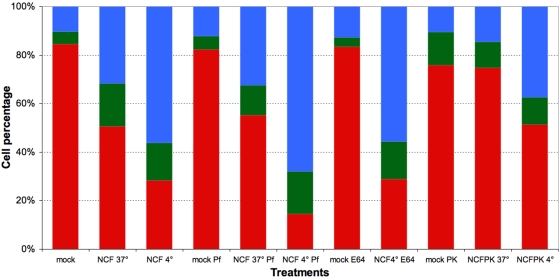
Effect on splenocyte survival of diverse pretreatments applied to the non-cytosolic trypanosome fraction (NCF).Splenocytes were exposed for 75 min to the non-cytosolic fraction corresponding to 4 108 trypanosome equivalents per ml. Mock, PBS; NCF 37°C and 4°C, non-cytosolic fraction kept at 37 or 4°C respectively for 24 h prior to incorporation onto the cells; Pf, E64 and PK, treatment of NCF with Pefablock or E64 or proteinase K respectively for 24 hours prior to incorporation onto cells. The three cell subsets represented are normocytic and annexinV/PI double negative (red, healthy), normocytic and annexinV/PI double positive (green, early necrosis), and microcytic and annexinV/PI double positive (blue, late necrosis). The values presented are means of three independent experiments.